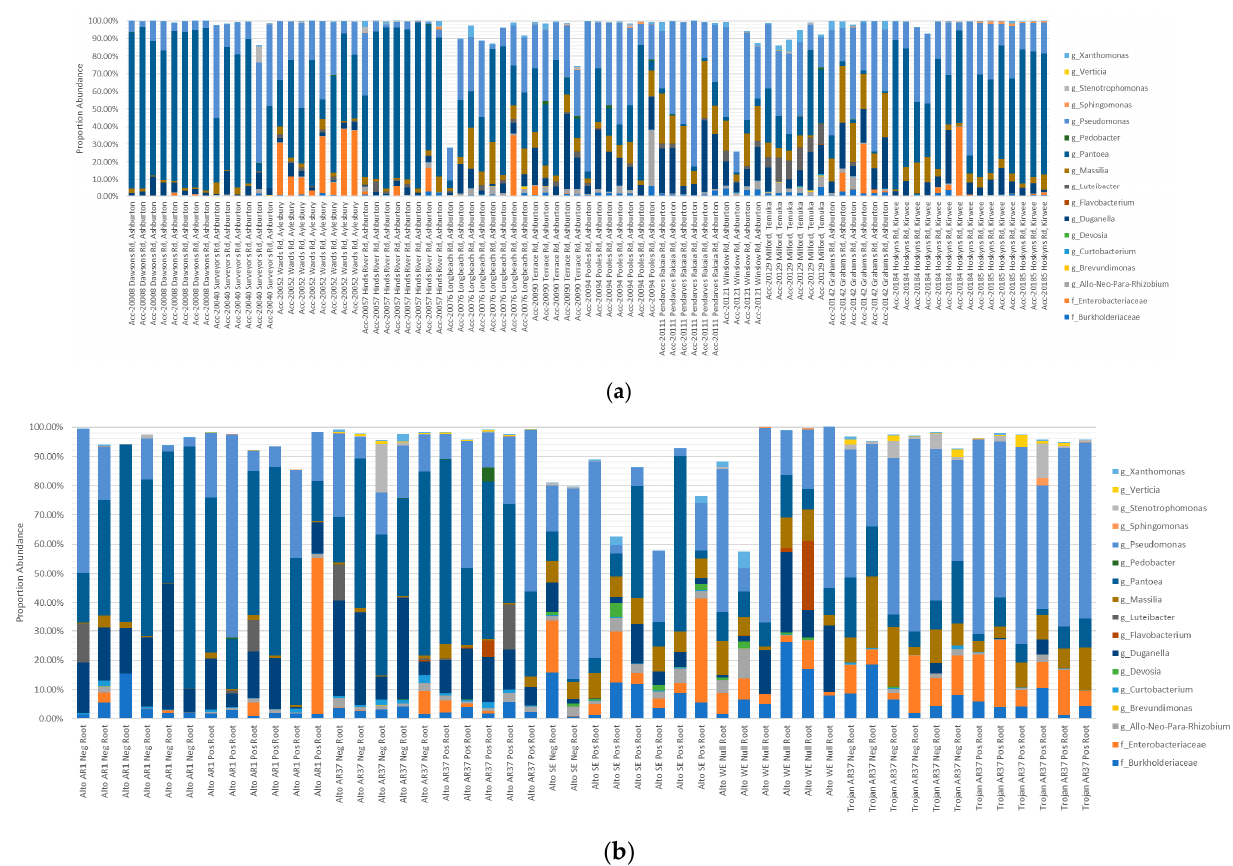
Figure 8. Comparison of the contribution of the 38 shared OTUs from Biogeography Seeds ( a ) and from Single Seeds ( b ). Table 3. Mapping of the 14 Rank 1 OTUs against isolates obtained from Lolium perenne . Any Rank (% Homology to Isolates Rank 1 (% of of Reps)